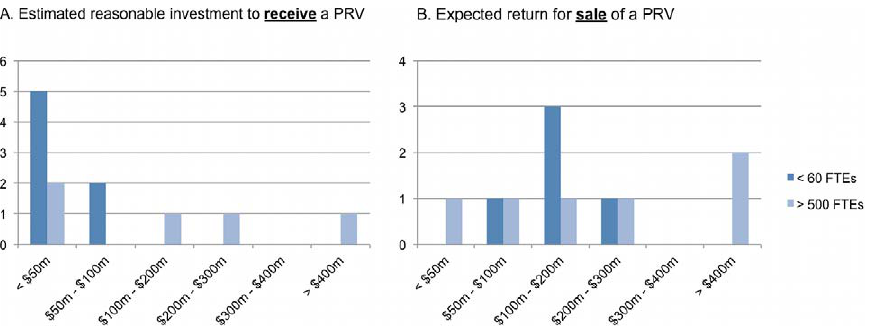
Figure 2. Industry perspectives with regard to priority review voucher (PRV) value. (A) Companies were asked to approximate the amount their company would spend to earn a PRV. On average, respondents indicated their company would find reasonable spending US $ 94 million (mode=US $ 25 million; median=US $ 25 million; SD= 6 US $ 119 million). (B) Respondents were asked to approximate the amount their company would expect to receive for the sale of a PRV. On average, respondents indicated their company would expect to receive US $ 188 million (mode=US $ 150 million; median=US $ 150 million; SD= 6 US $ 142 million). Responses were identified into ‘‘large’’ companies ( . 500 FTEs) and ‘‘small’’ companies ( , 60